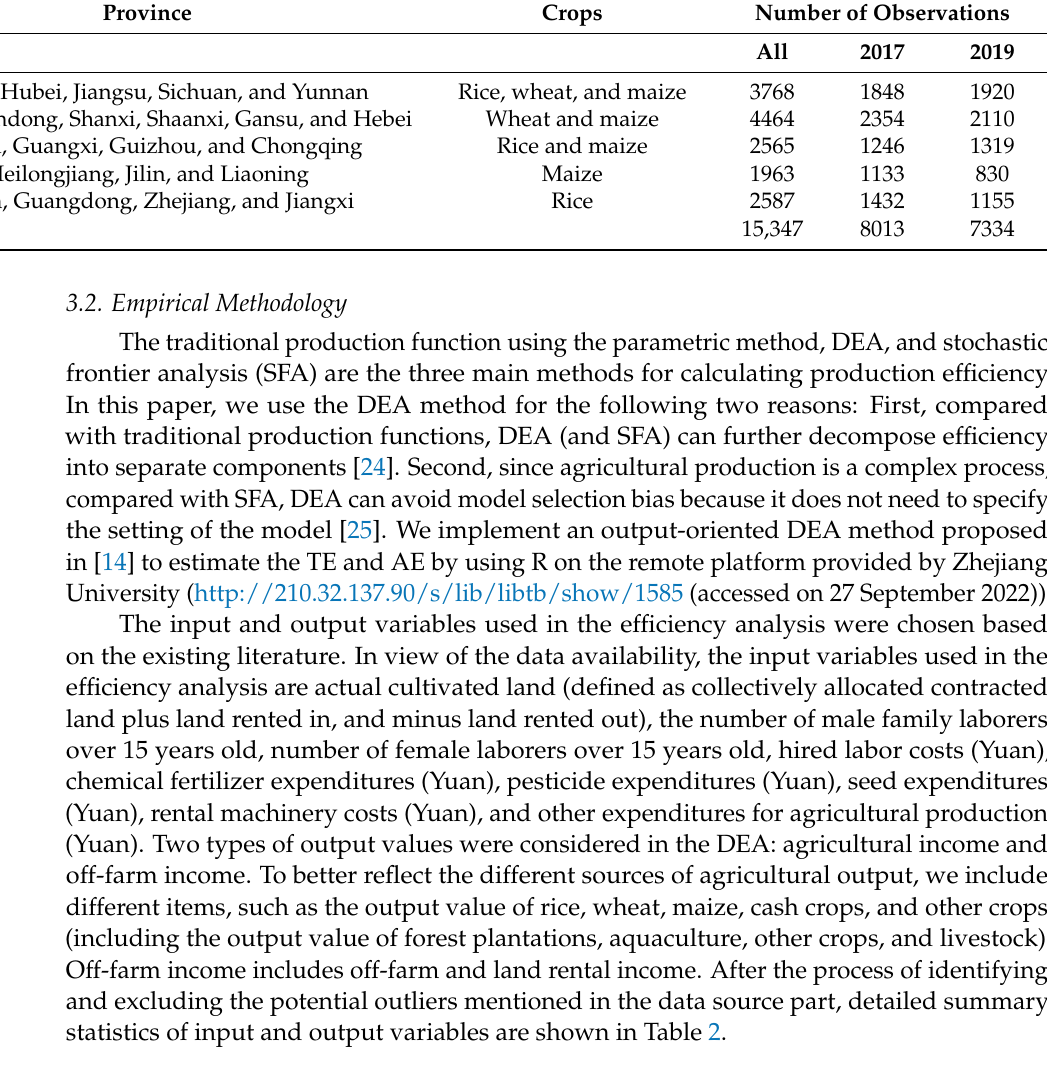
Table 2. Summary statistics of inputs and outputs of rural